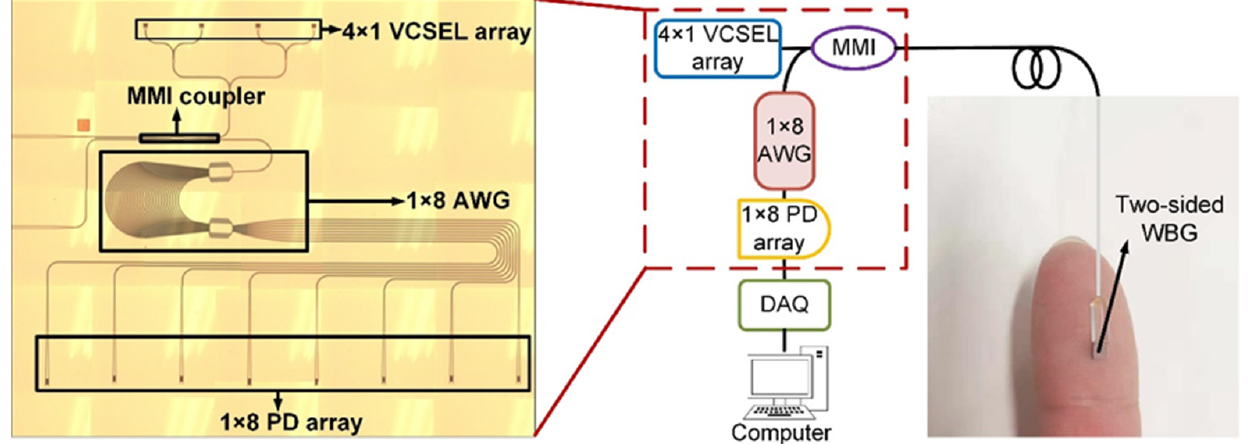
Figure 9. The layout and principle of the PIC of an AWG interrogation system. Table 3. Experimental results of temperature measurement in AWG interrogation PIC. Voltage (V)